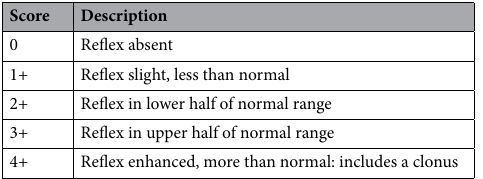
Table 1. NINDS for deep tendon reflex assessment. NINDS National Institute of Neurological Disorders and Stroke.